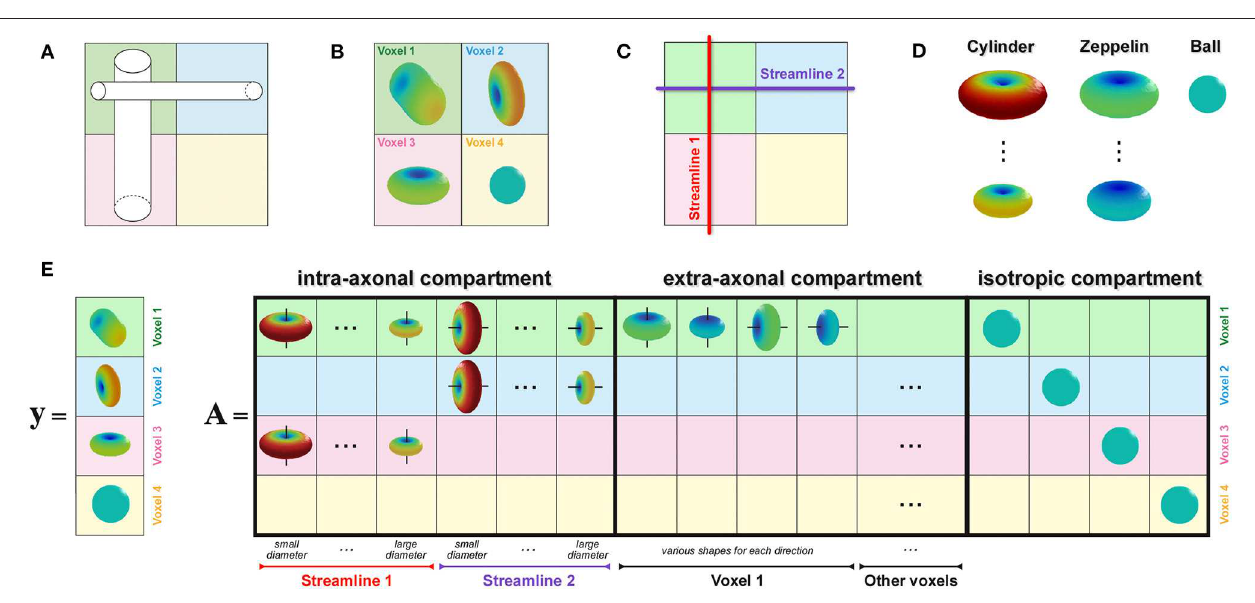
Frontiers in Neuroscience |